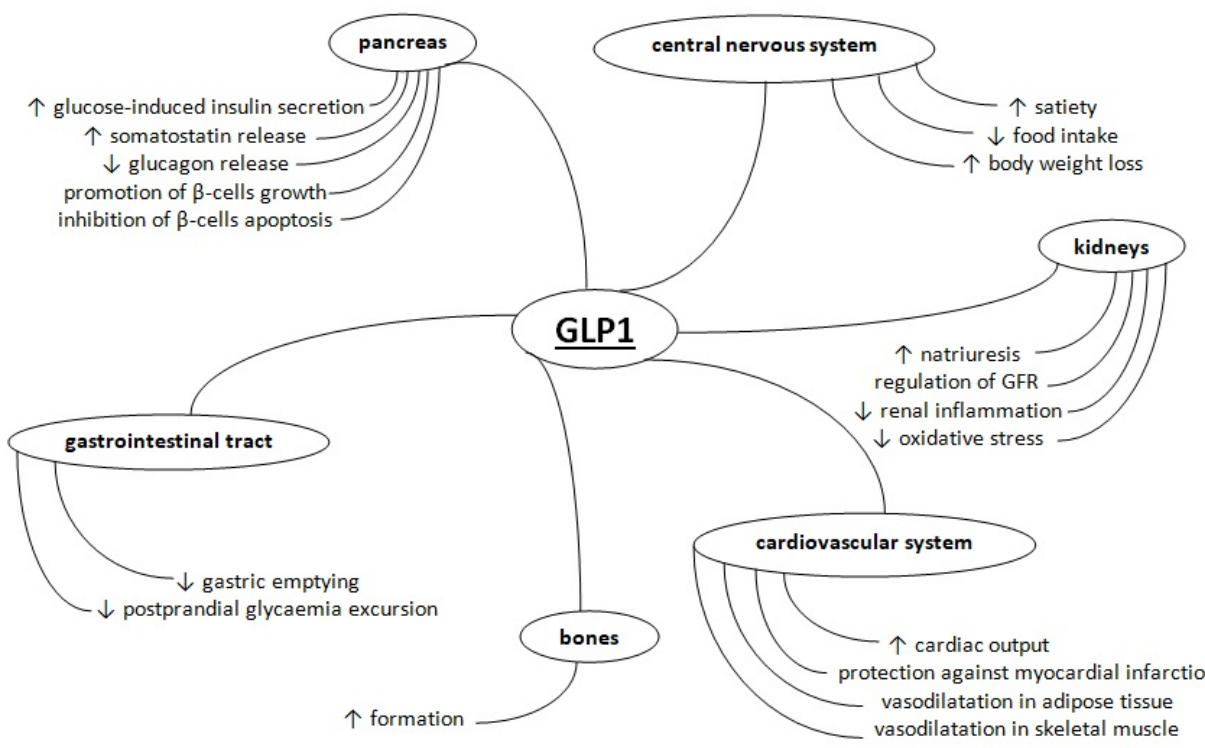
Figure 1. The influence of GLP1 on different tissues.